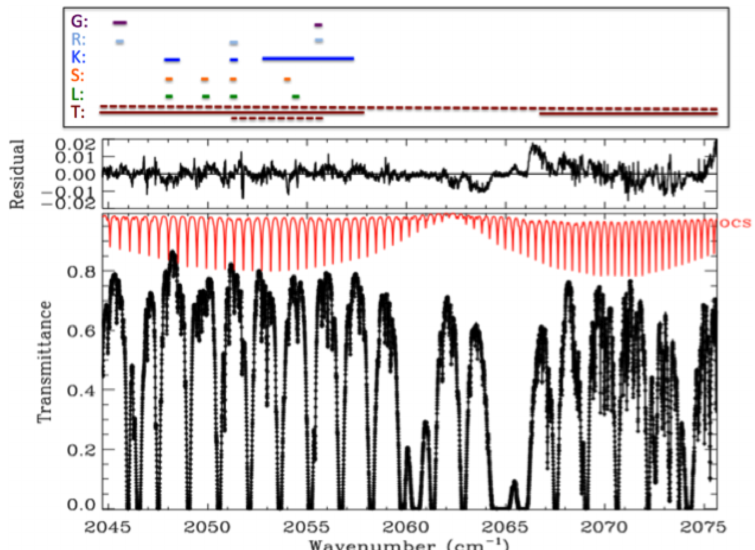
Figure B1. Spectral coverage of the evaluated windows superimposed above a fit to a ground-based MkIV spectrum measured from JPL at 58 ◦ SZA. The black points and line are the measured and calculated spectra, respectively. The red trace shows the OCS absorption, and the strong lines extend from P 38 on the left to R 36 on the right. In the top panel, the horizontal bars show the coverage of the windows evaluated in the study. G represents the windows used by Griffith et al. (1998), R by Rinsland et al. (2002), and so on. The brown solid lines labeled T were considered the best. The brown dotted lines were evaluated but rejected. This figure omits window no. 6 centered on the P 50 line at 2038.95cm − 1 , used by Krysztofiak et al.